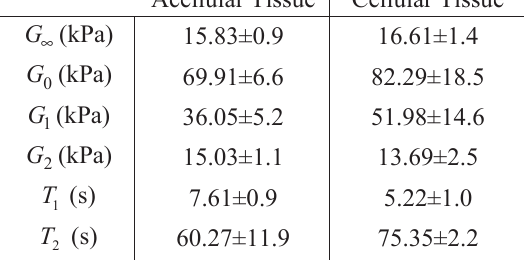
Table 2: The mean coefficients for the relaxation modulus and time constants as calculated by fitting to the small strain indentation data given in figures 8 and 14. Errors given to one standard